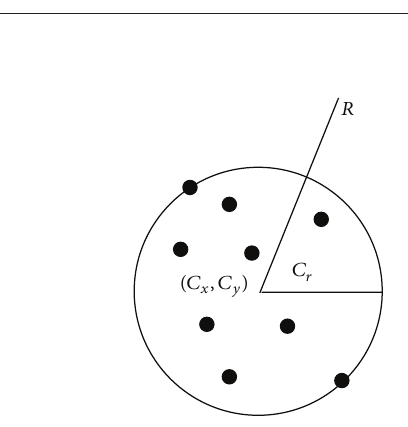
Figure 10: A circular formation. Figure 11: A doughnut